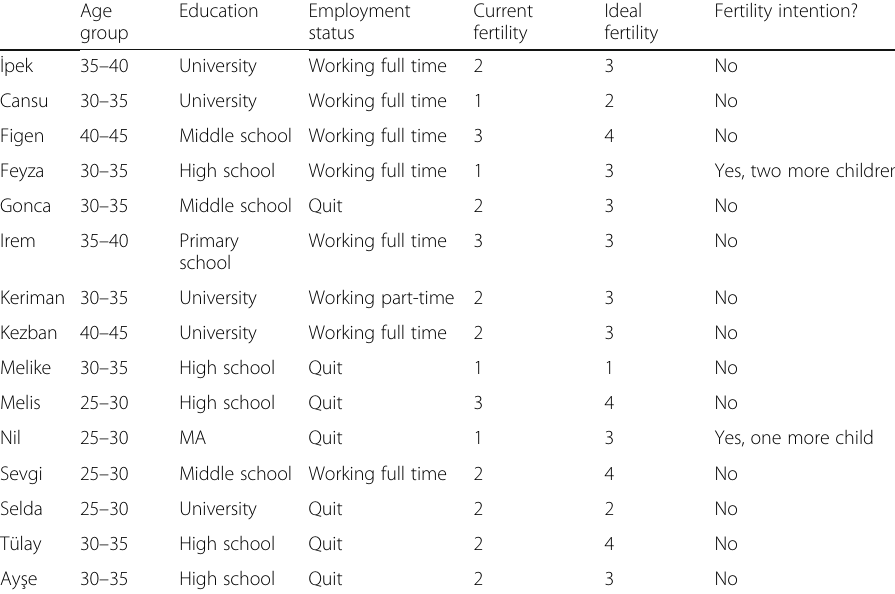
Table 1 Respondents ’ demographic characteristics, ideal fertility, and fertility